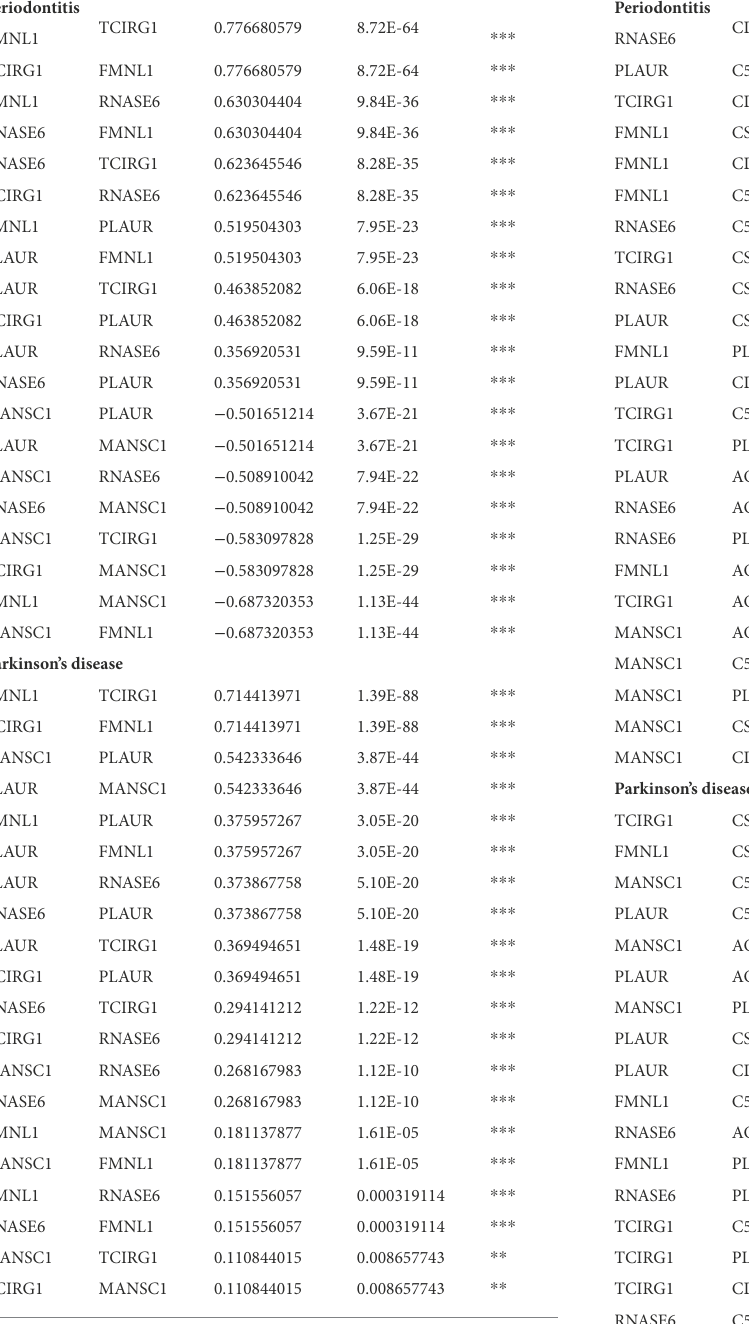
TABLE 6 The correlation between hub crosstalk genes and hub IRRGs in periodontitis and Parkinson’s disease. Hub gene Hub IRRG Cor. p -value